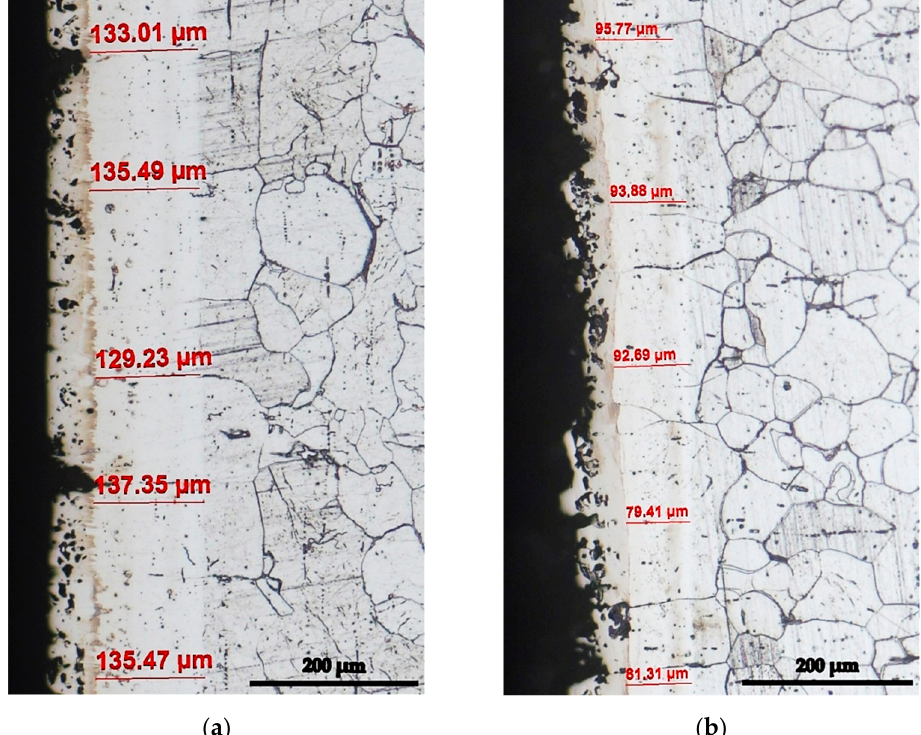
Figure 6. The effects of changes in the growth kinetics of the free porous zone with the variation of Figure 1. The effects of change in the growth kinetics of the free porous zone with the variation the holding time with temperature (1150 °C) and the proportion of active component (FeSi75C) from of the holding time with temperature (1150 ◦ C) and the proportion of active component (FeSi75C) the powdered solid mixture. Etchant: Nital 2%. ( a ) 1150 °C/5 h; 40% FeSi; 9% NH 4 Cl (exp. 3); ( b ) from the powdered solid mixture. Etchant: Nital 2%. ( a ) 1150 ◦ C/5 h; 40% FeSi; 9% NH 4 Cl (exp. 3); 1150 °C/1 h; 60% FeSi; 9% NH 4 Cl (exp. 4). ( b ) 1150 ◦ C/1 h; 60% FeSi; 9% NH 4 Cl (exp.